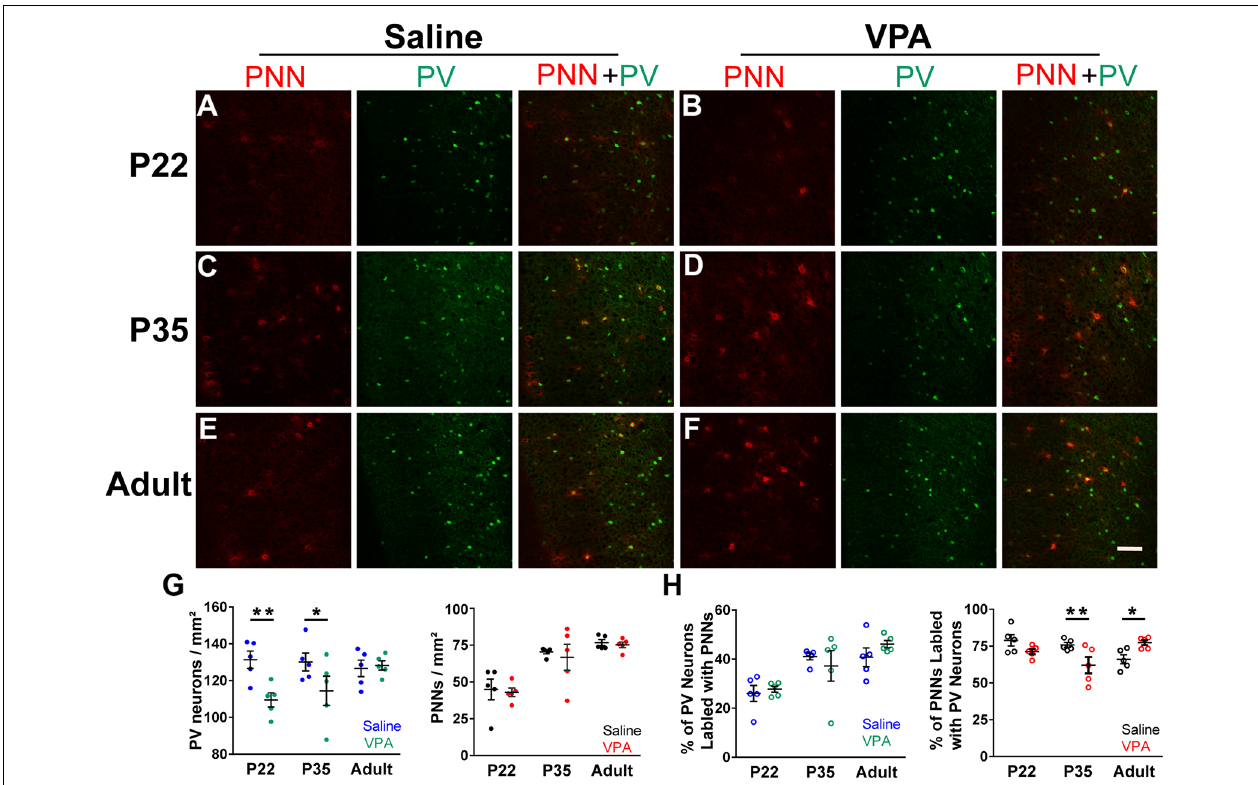
FIGURE 1 | Density of parvalbumin (PV) + neurons and Wisteria floribunda agglutinin (WFA) (+) perineuronal nets (PNN) in prelimbic prefrontal cortex (PrL-PFC) across development in saline and valproic acid (VPA) mice. (A–F) Representative images of PV (green) and PNN (red) staining in the PrL-PFC of saline and VPA mice. Scale bar, 100 µ m. (G) The density of PV + neurons (left) and PNN (right) in PrL-PFC. (H) Percentage of PV + neurons ensheathed by PNN (left) and PNN wrapped PV + neurons (right). Blue, green, black, and red points in panel (G) represent the density of PV + neurons in the saline group and VPA group, the density of PNN in the saline group and VPA group, respectively. Blue, green, black, and red circles in panel (H) represent the percentage of PV + neurons ensheathed by PNN in the saline group and VPA group, PNN wrapped PV + neurons in the saline group and VPA group, respectively. Black lines indicate Mean ± SEM. n = 5 mice for each group. Linear regression models were applied to compared various outcomes between groups using mice as the statistical units. * P < 0.05, ** P < 0.01.